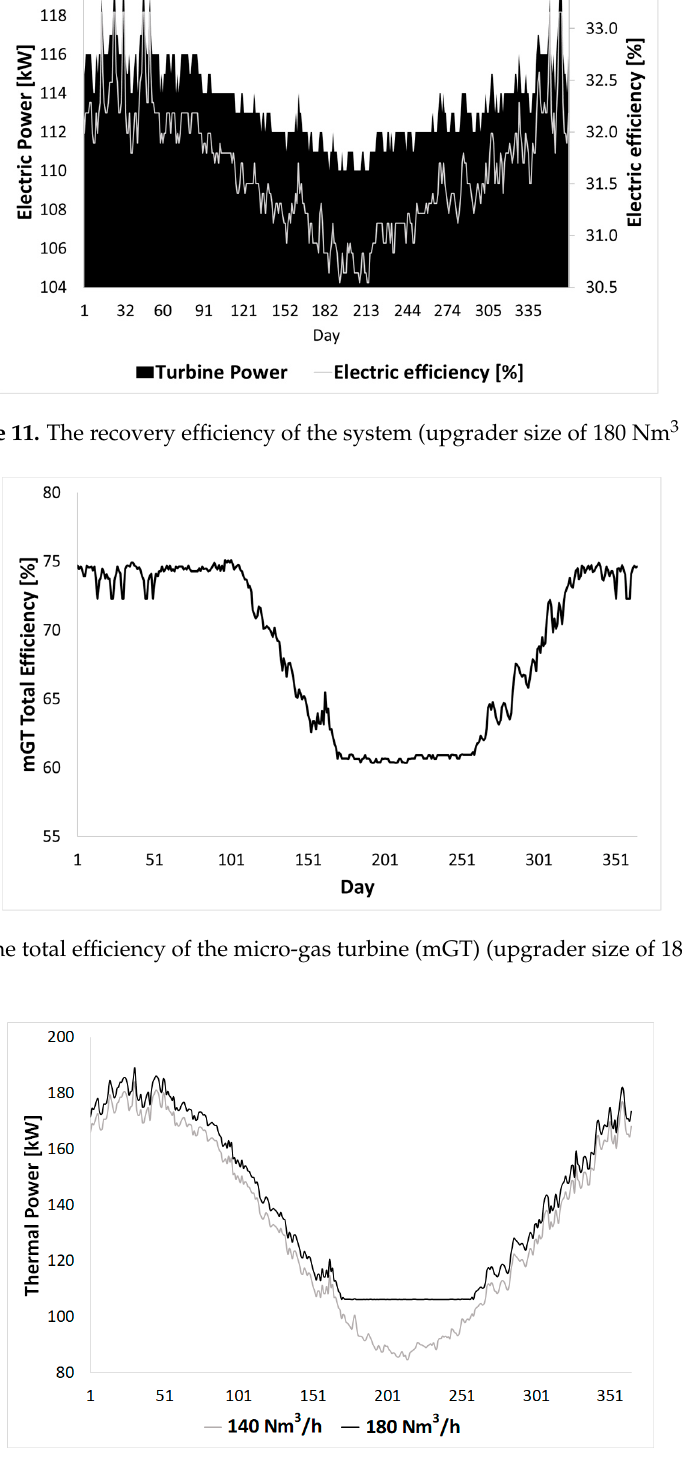
Figure 13. The thermal power required by the system (upgrading and sludge) for two different values of upgrading unit size.